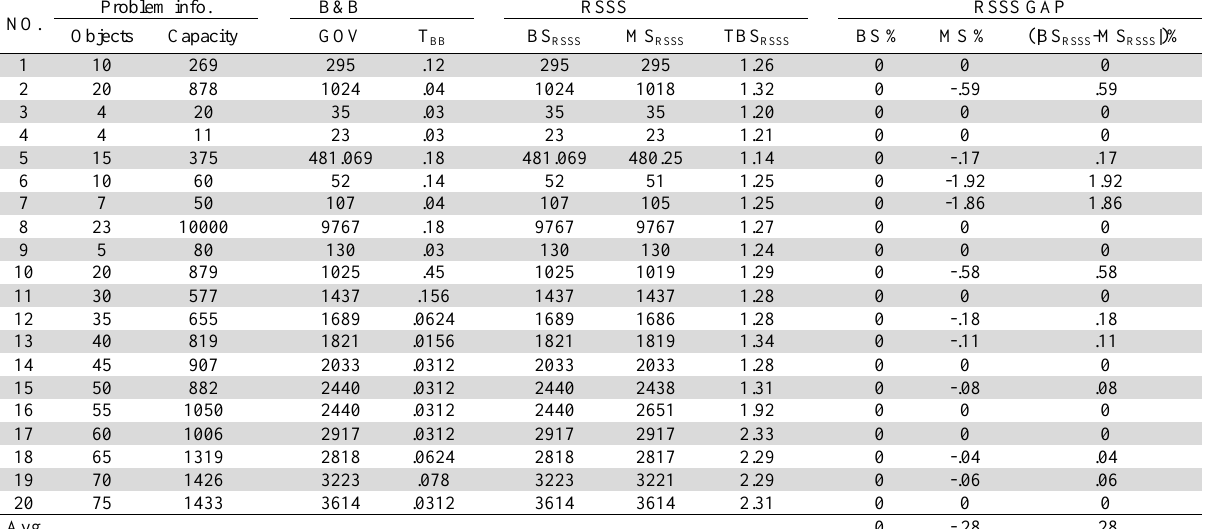
The obtained results and comparison from B&B and RSSS runs Problem info. NO.